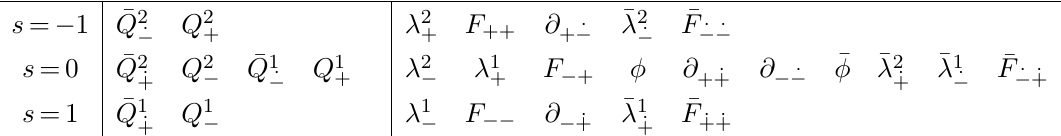
Table 2 . s quantum numbers of the N = 2 Poincaré supercharges and fields in the free vector multiplet, ¯ D ⊕ D 0(0 , 0) 0(0 , 0)